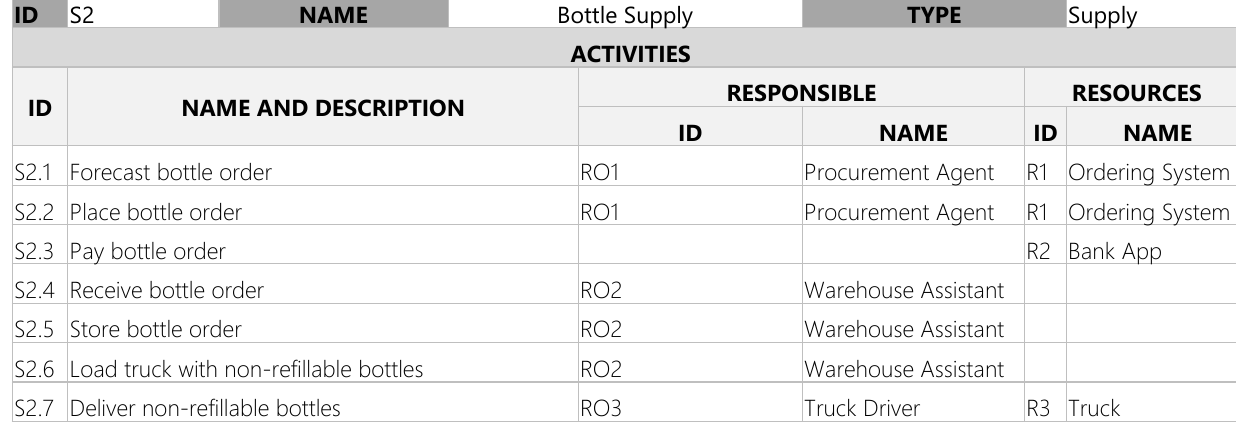
Figure 16. S2 Catalogue.